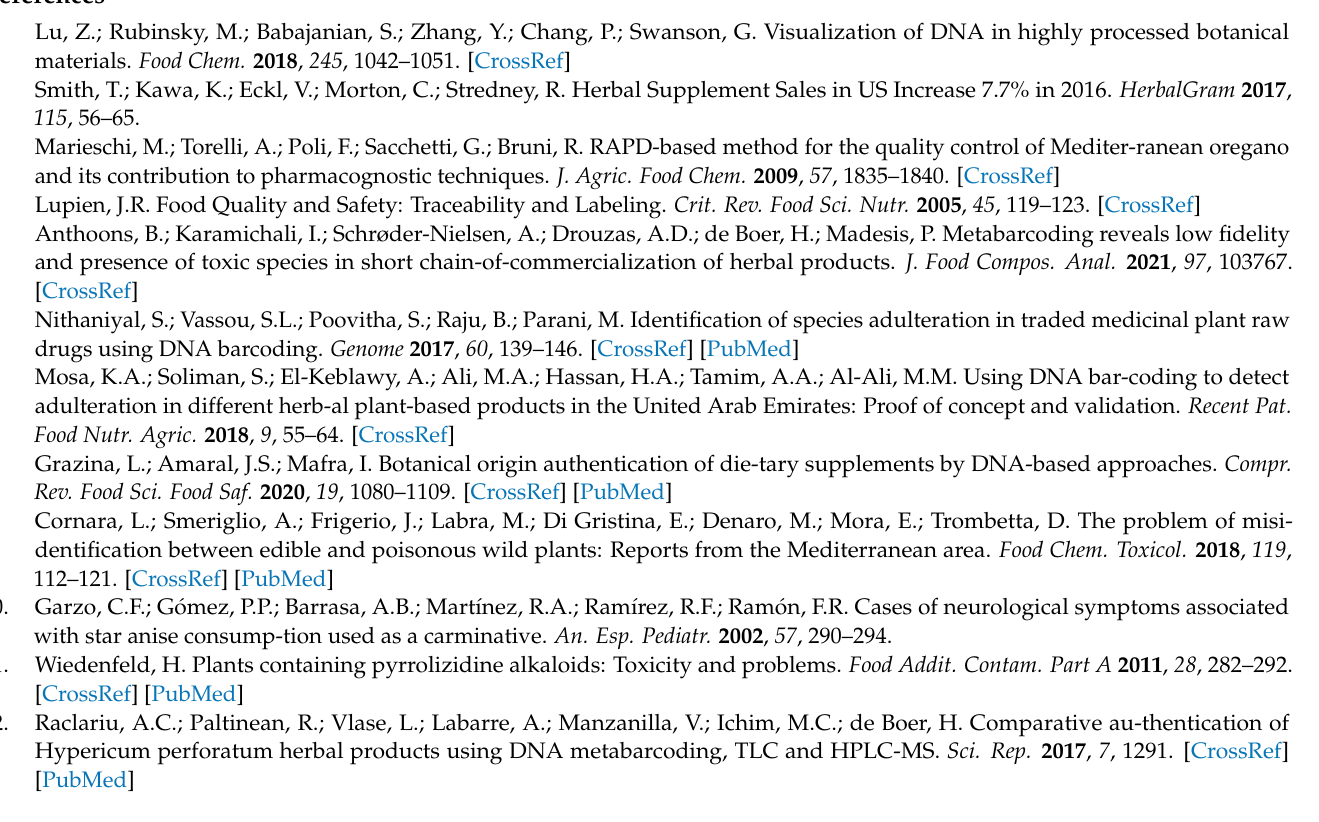
(Figure 3) are available in the .xls file, Table S2: gDNA concentrations, Table S3: dataset of HTS sequencing percentages compared to expected samples, Table S4: beta-diversity analysis of ITS2 samples compared to expected samples, Table S5: beta-diversity analysis of psbA-trnH samples compared to expected samples, Table S6: primer